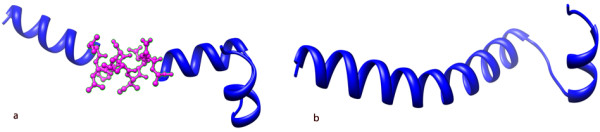
a, 3D Model showing Epitopic region of gp41with maximum affinity, b, Tertiary structure of gp41 contains 2 helices.